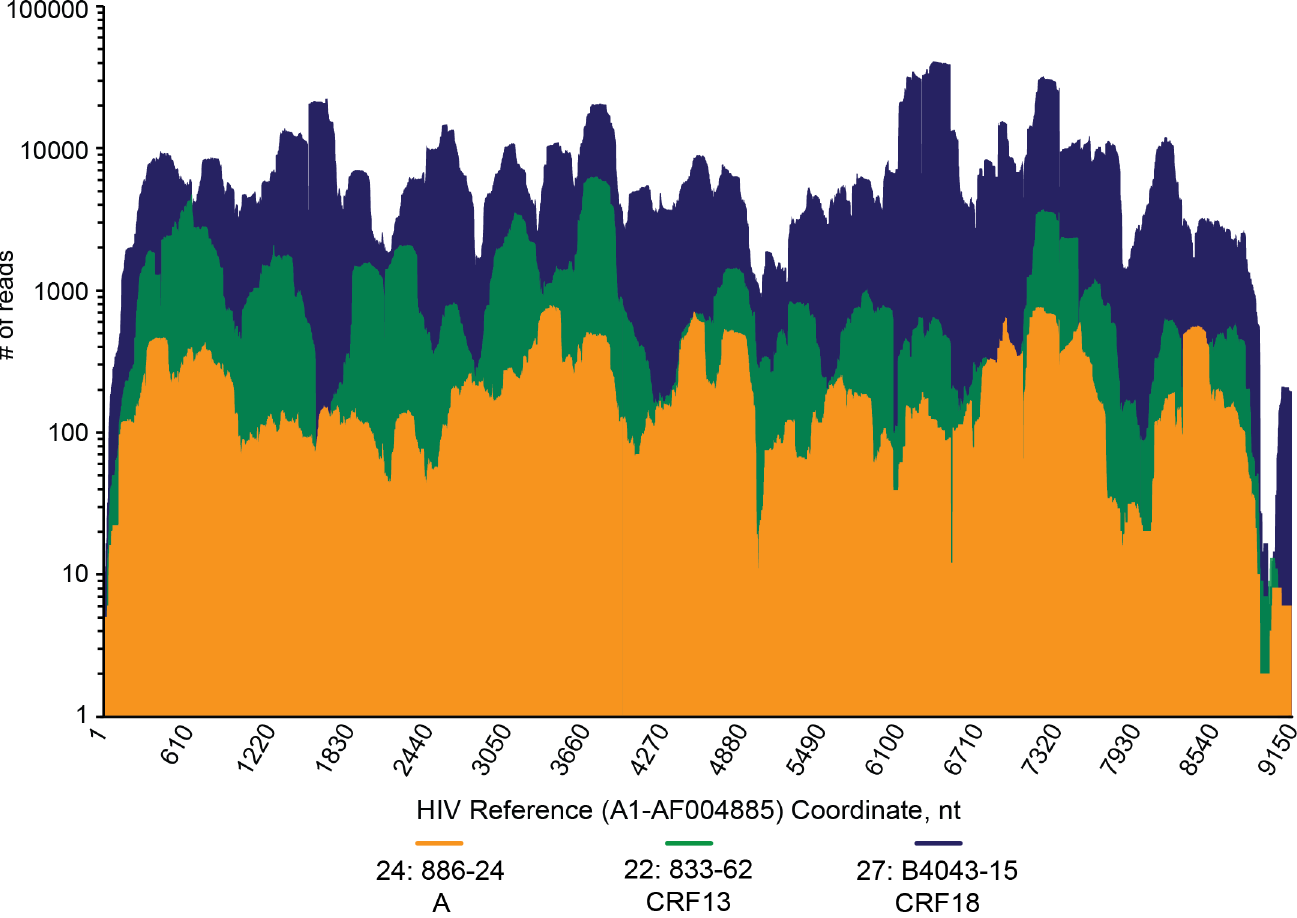
Fig 1. HIV genome coverage is uniform and complete but varies in sequence depth. Three representative specimens sequenced by NGS with a wide range in percentage of HIV reads were selected and aligned to the A1-AF004885 reference genome to demonstrate the uniformity of genome coverage regardless of read depth. Coverage is expressed as number of reads at each nucleotide position along the length of the HIV genome. Strain/mean read number: 833-62/1085, green; 886-24/223, orange; B4043-15/7939, blue.